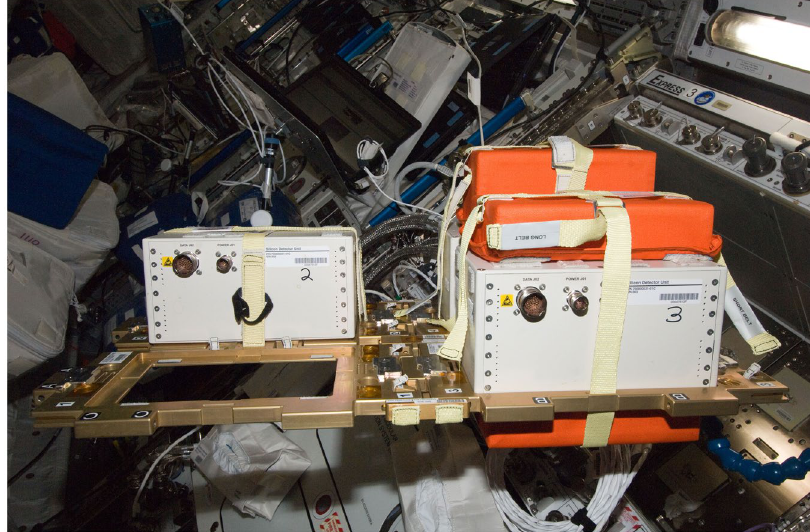
Figure 1. Configuration during the ALTEA-shield measurements. Three of the ALTEA SDUs are deployed on a flat configuration using a modular support structure that can hold four SDUs. The Digital Acquisition Unit (DAU) will be positioned in the empty space visible in Fig. 2. One SDU (n. 2, on the left) is the reference SDU, without the shielding tiles. Tiles of different thickness are positioned on the SDUs n. 1 and n. 3 (on the right, in orange).